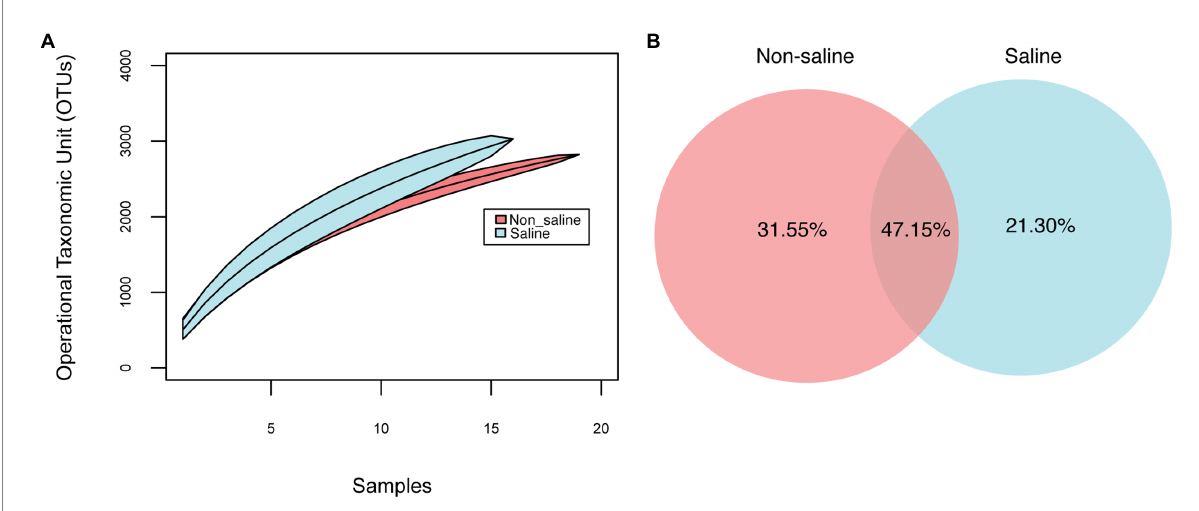
FIGURE 2 Species accumulation curves, unique and shared bacterial OTU analyses. (A) Operational taxonomic unit (OTU) accumulation curves at 97% sequence similarity and (B) shared and unique OTUs of date palm-associated soil between irrigation sources (non-saline vs. saline groundwater irrigation). The unique and shared OTUs are expressed as percentages of total OTUs (5,155).